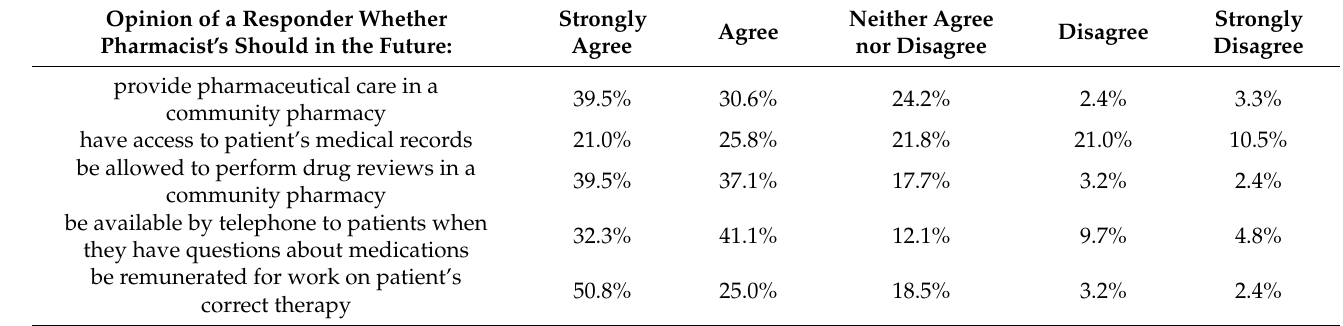
Table 5. Nurses’ future expectations in the field of cooperation with a pharmacist in general. ( n = 124).